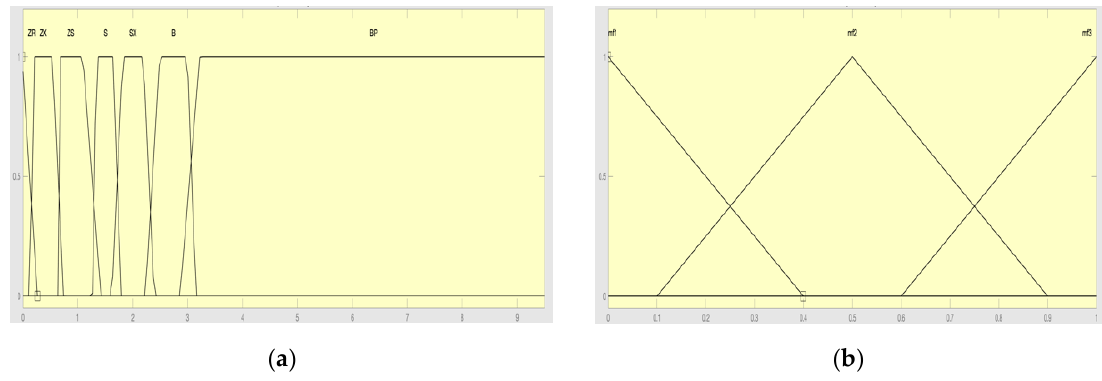
Figure 1. Membership functions of input variables: ( a ) fuzzy subset of p and ( b ) fuzzy subset of SOC.